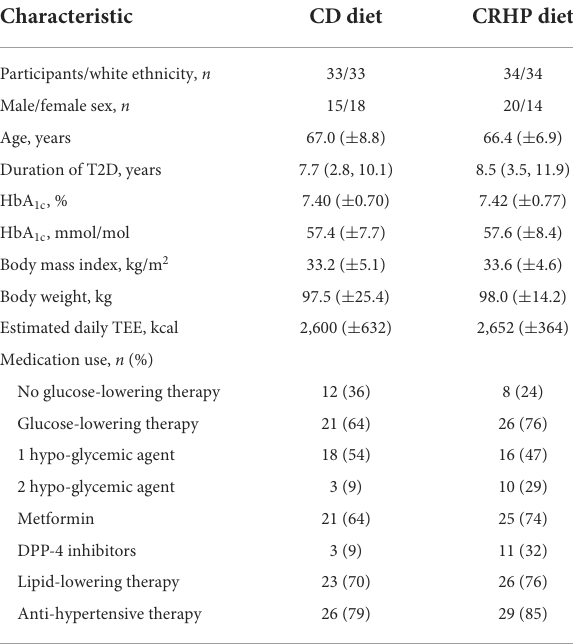
TABLE 1 Baseline characteristics of participants with